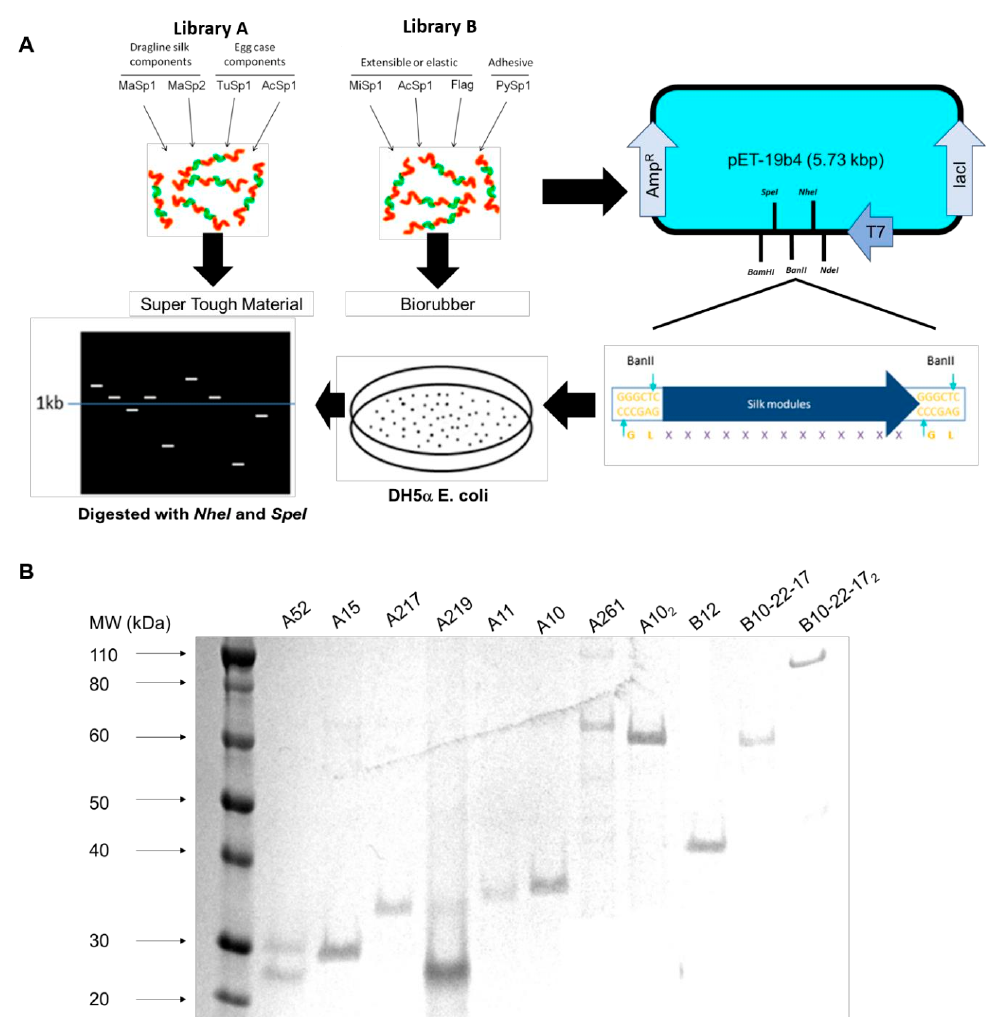
Figure 2. Establishment of the recombinant DNA libraries. ( A ) Generalized BanII restriction enzyme mediated cloning strategy for establishment of DNA library. ( B ) SDS-Page of select purified